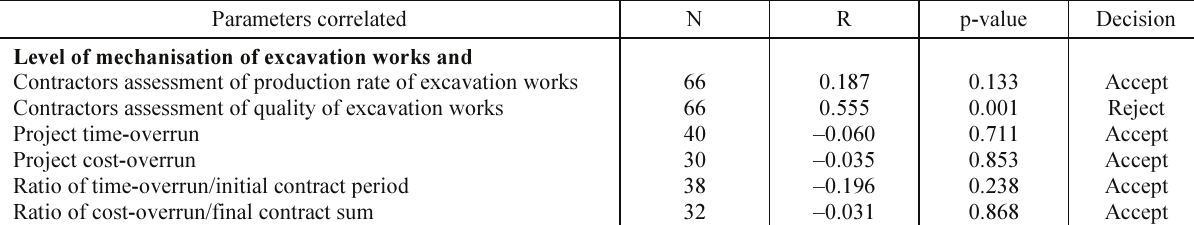
Table 10. Results of Spearman test of correlation between the level of mechanisation of excavation works and project outcome Parameters